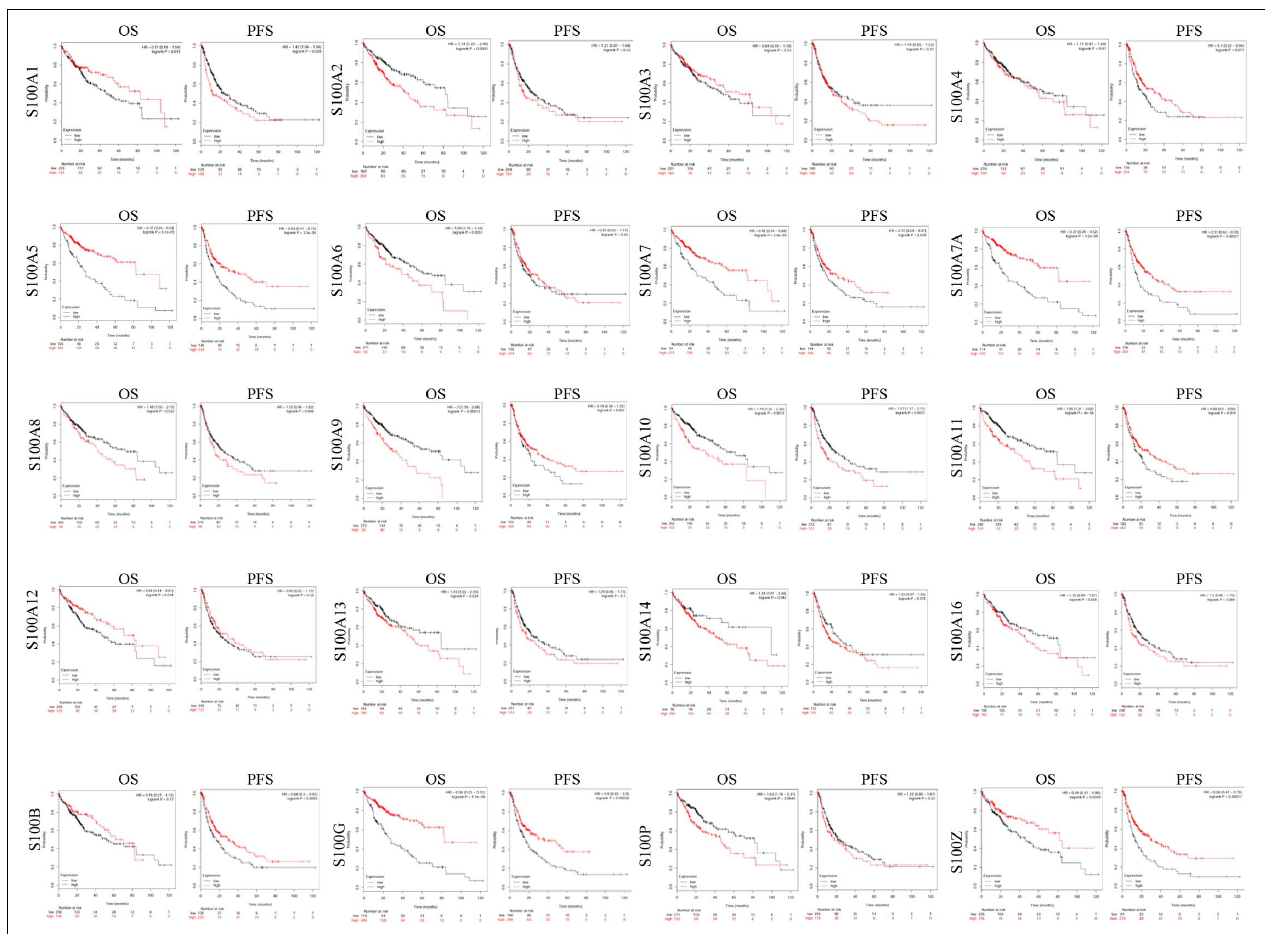
FIGURE 5 | The prognostic value of S100s mRNA expression in HCC patients (Kaplan-Meier Plotter). Higher mRNA expressions of S100A6/S100A10/S100A11/ S100A13/S100A14/S100P were shown to have shorter survival time, while higher expression of S100A12 was associated with longer survival time. OS,